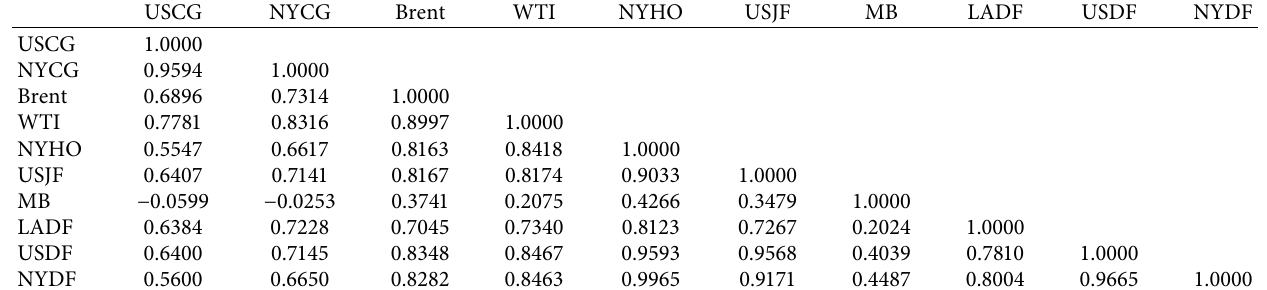
Figure 1: (a) MAE and (b) RMSE improvement of I-cLV over the VAR model at each kind of commodity for lead time t +1. Table 6: Pearson’s correlation between diferent commodities (2019).